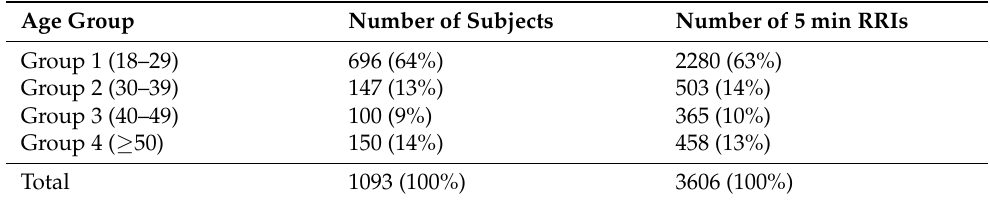
Table 1. Number of subjects and 5 min RRI samples from each age